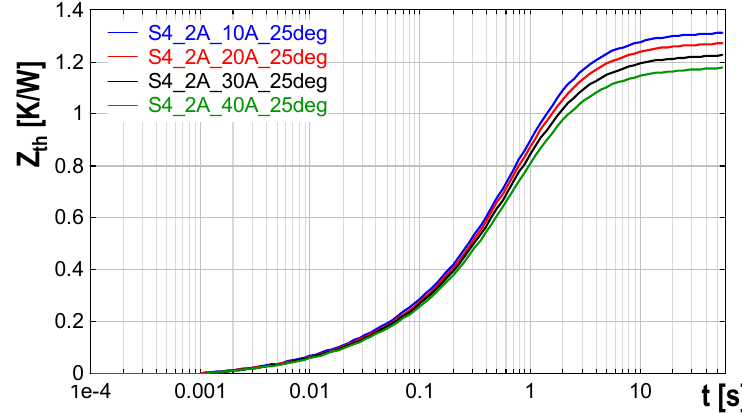
Figure 16. Z th curves of a power module at I H heating currents, 10 A to 40 A [4].